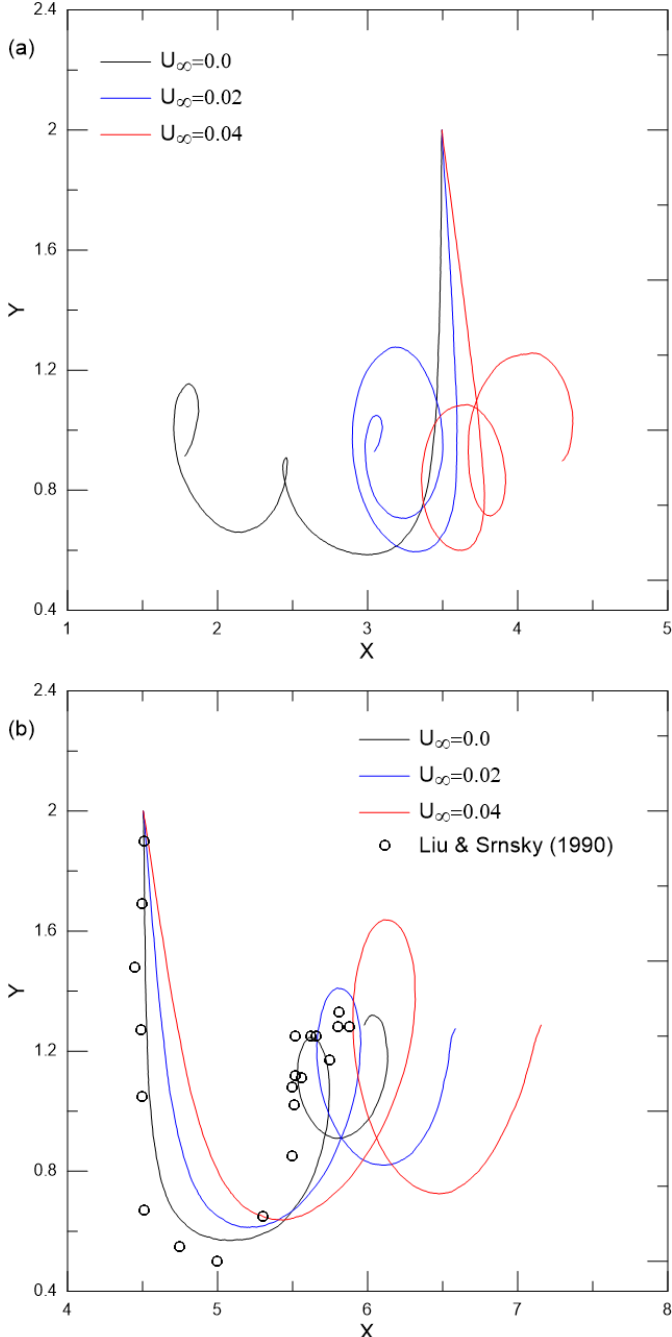
Figure 8. Crosswind interferences on the predicted trajectories of the vortical structures from wing tips (Ri = 0.0 and Re = 7650): ( a ) left side and ( b ) right side [9]. For configuration without both crosswind and buoyancy effects, after interacting with the hydrodynamic boundary layer formed on the ground plane, the centroid of the right vortical structure makes an upward trajectory up to a maximum altitude of approximately y = 1.32 (Figure 8b). On the other hand, under influence of different crosswind velocity values, maximum altitudes around y = 1.41 and 1.63 are identified for velocities of U ∞ = 0.02 and 0.04, respectively (Figure 8b). It is evident that there is coupling between these primary structures and the secondary structure generated on the ground plane, which induces a more pronounced recirculation for the primary vortical structures. There is also a